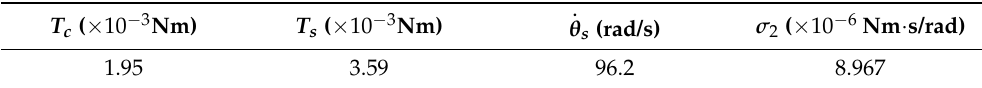
Figure 5. Static parameters identification curve. Table 1. Static parameters of the LuGre model.